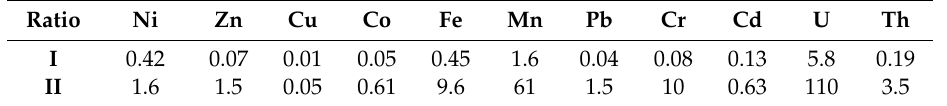
Table 7. Ratios of metal concentrations in process waste to those in the leached ore from a secondary leaching